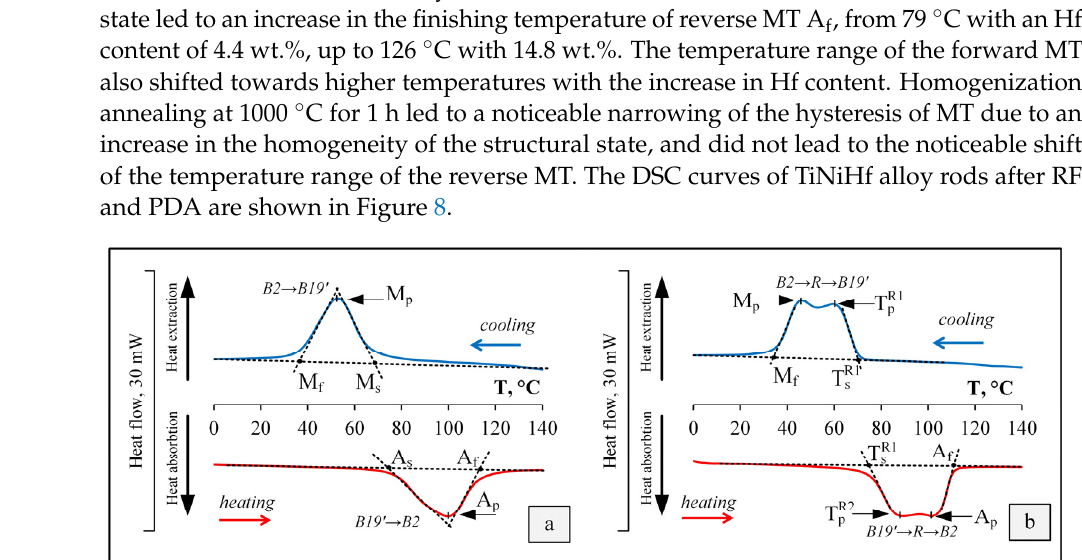
Figure 8. Calorimetric curves of the TiNiHf rods after RF ( a ) and RF + PDA at 550 °C for 2h ( b ).